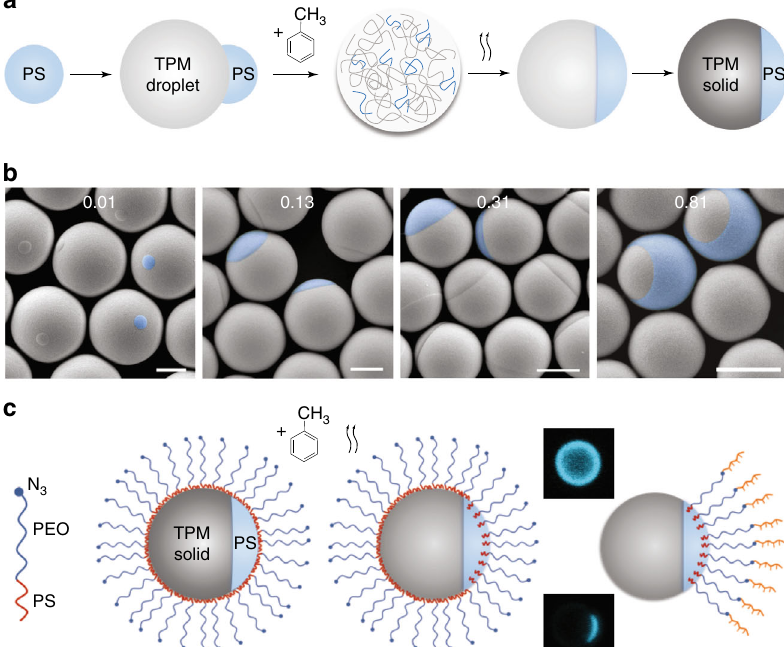
Fig. 1 Janus particle fabrication. a Left to right: A reactive silicone oil droplet, 3-(trimethoxysilyl)propyl methacrylate (TPM), is heterogeneously grown on the surface of a polystyrene (PS) microsphere by hydrolysis and condensation. Toluene is then added to swell the TPM-grown PS particles, forming fully liquid emulsion droplets in which PS and TPM oligomers are homogenously dissolved. Next, the PS and TPM oligomer droplets phase-separate as toluene gradually evaporates, resulting in a biphasic colloid composed of a PS cap and a TPM oligomer body. Finally, the TPM oligomer body is highly cross-linked by radical polymerization resulting in monodisperse Janus particles composed of solid PS and TPM patches (PS-TPM particles). b SEM images show PS- TPM Janus particles with various patch ratios ranging from 0.01 to 0.81. False color aids identi fi cation of the PS patches. Scale bar = 1 μ m. c Amphiphilic block copolymers, consisting of a hydrophobic polystyrene (PS) block and a hydrophilic poly(ethylene oxide) (PEO) block with an azide functional end- group (PS- b -PEO-N 3 ), adsorbs to the entire surface of the PS-TPM particle (PS- b -PEO-N 3 are not drawn to scale: PS- b -PEO-N 3 block is ~10 nm thick; particles are ~1000 nm in diameter). Adding toluene leads to selective swelling of the PS patch, as the PS patch is not crosslinked, while the TPM is highly crosslinked. The PS block of the PS- b -PEO-N 3 to penetrates the swollen PS patch. After deswelling, the PS block is trapped inside the PS patch while the PEO block remains outside. DBCO-functionalized DNA (DBCO-DNA) is coupled to the azide functional group at the end of the PEO brush using SPAAC 44 . The block copolymer coupled with DNA on the TPM surface is removed by washing with a surfactant solution (Triton X-100, 1-wt%). The fl uorescence images show the DNA-coated Janus particles before (top) and after (bottom) washing, con fi rming that only the PS patch is coated with DNA, which is fl uorescently